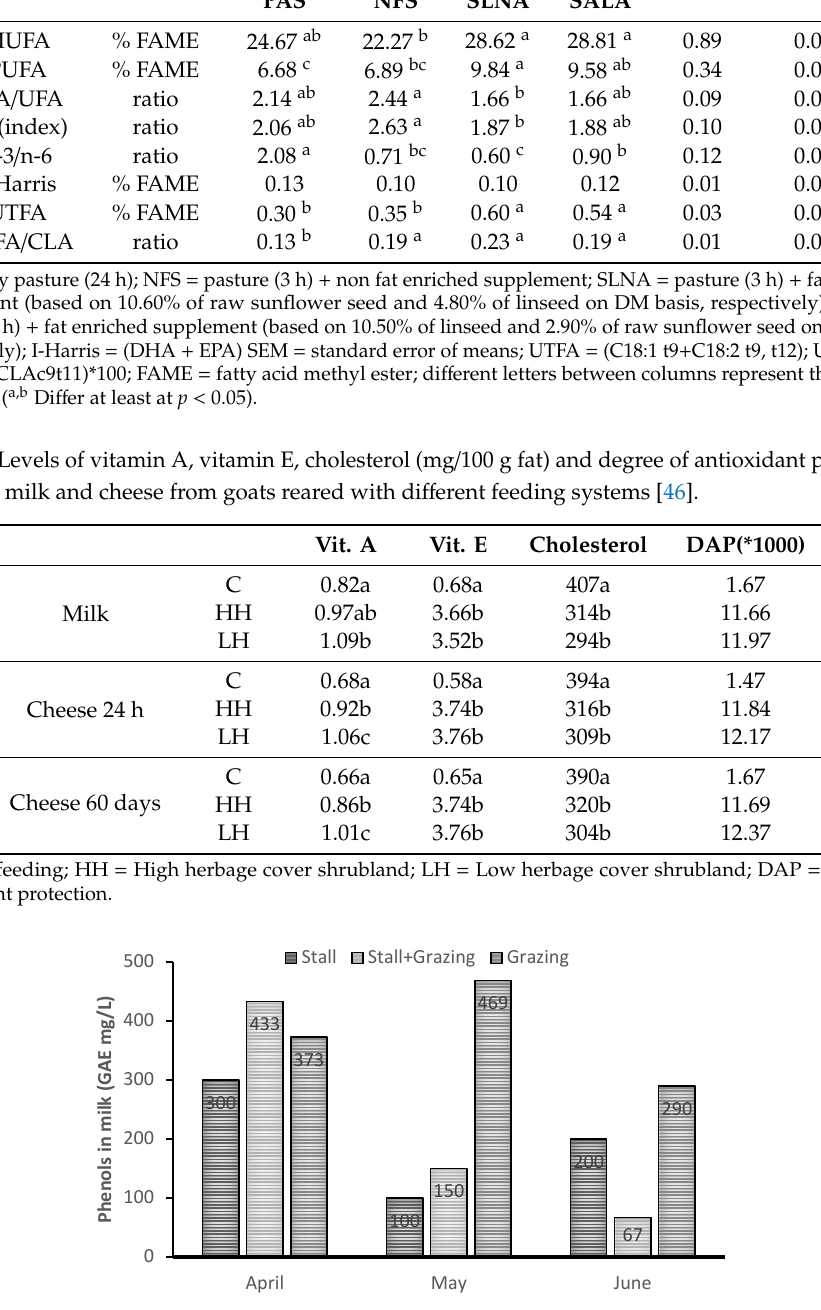
Figure 8. Effect of different goat feeding systems on milk phenols content [47]. Figure 8. E ff ect of di ff erent goat feeding systems on milk phenols content